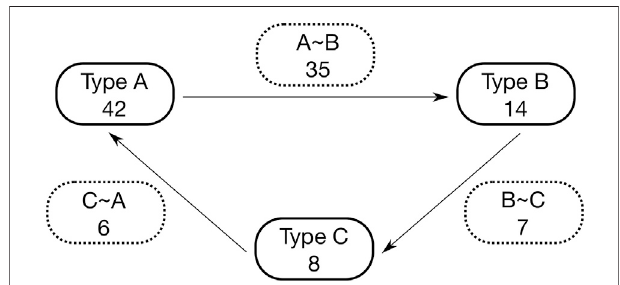
FIGURE 2 | Frequency diagram of attested types in our 106 language sample.Notethatsixlanguageshavemorethanonetype;OriyaisType-Aand Type-BC, Kumzari is Type-A and Type-C, Kupia, Chitpavani Goan Konkani, Goan Konkani, and Varhadi-Nagpuri are Type-B and